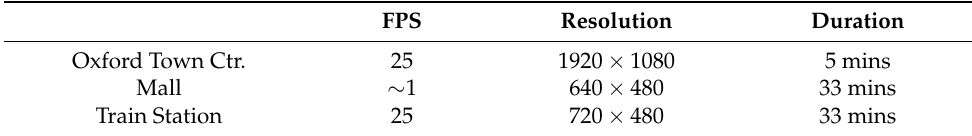
Table 2. Information of each pedestrian dataset. FPS Resolution Duration Oxford Town Ctr. 25 1920 × 1080 5 mins